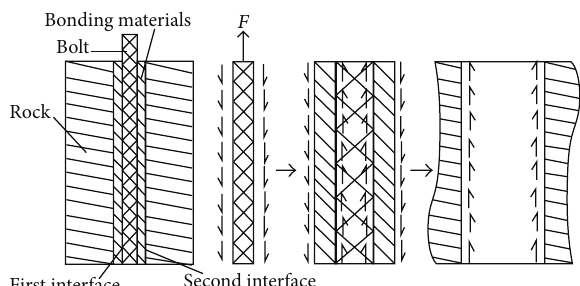
Figure1:Thestructureofanchoragebodyanditsstressdistribution.